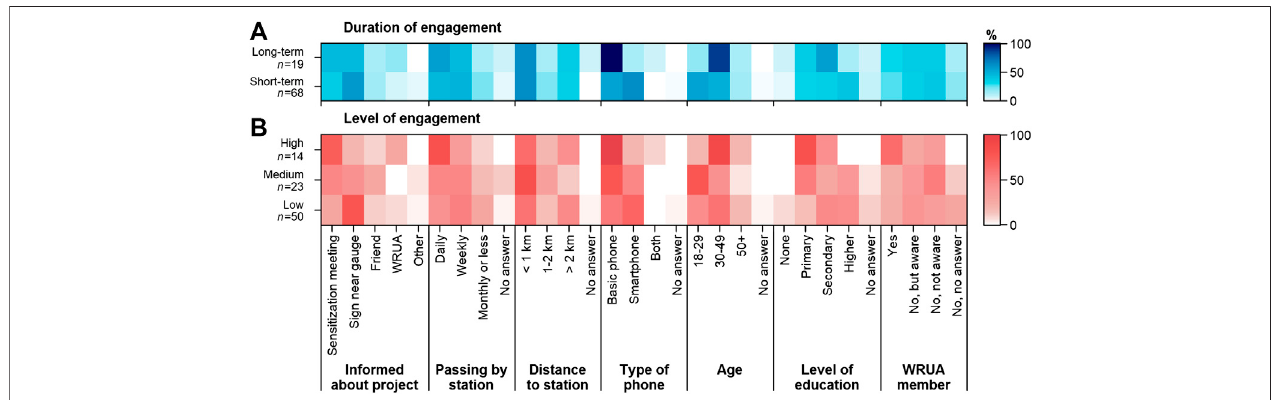
FIGURE3| Characterization oftheparticipantsofthecitizen science watermonitoring projectin theSondu-Miriu basin, Kenya,accordingtodifferentengagement classes,expressedaspercentageofrespondentswithineachclass.ThedurationofengagementisbasedonwhethertherespondentcontinuedsendingdataafterJune 2017.The level of engagement isbased on the number ofvalid measurements contributed betweenApril2016and June 2017 (Low (cid:2) 0 – 1, Medium (cid:2) 2 – 9,High (cid:2) 10 or more). n (cid:2) number of respondents within each engagement class; WRUA (cid:2) Water Resource Users Association.